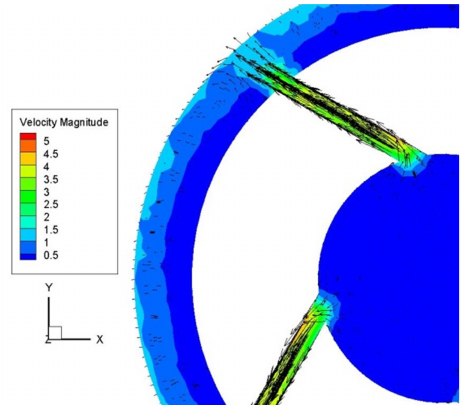
Fig. 10. Velocity vector of radial hole injection.